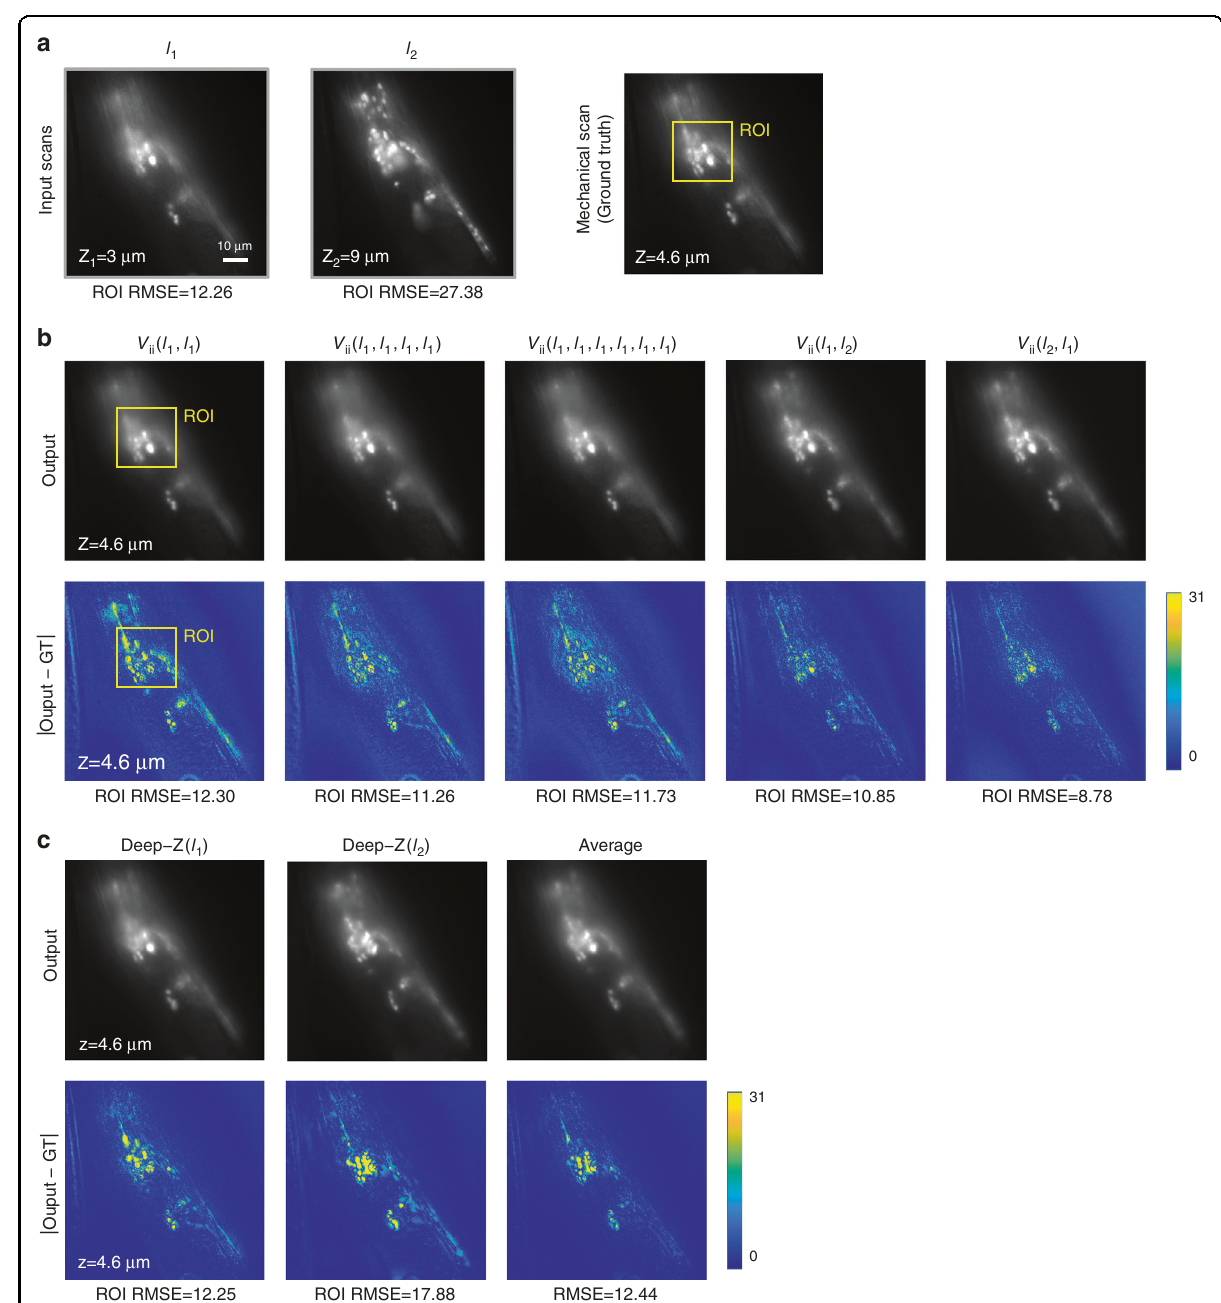
Fig. 7 Repetition invariance of Recurrent-MZ. Recurrent-MZ was trained with inputs ( M = 2) sorted by their relative distances ( dz ) to the output plane, but tested on a new sample by repeatedly feeding the input image ( I 1 ) to test its repetition invariance. a The input images and the ground truth image obtained by mechanical scanning (with an axial spacing of 0.2 μ m), b the Recurrent-MZ outputs and the corresponding difference maps of repeated I 1 , i.e., V ii ( I 1 , I 1 ), V ii ( I 1 , I 1 , I 1 , I 1 ) and V ii ( I 1 , I 1 , I 1 , I 1 , I 1 , I 1 ) as well as V ii ( I 1 , I 2 ) and V ii ( I 2 , I 1 ), c the outputs and corresponding difference maps of Deep-Z with a single input image ( I 1 or I 2 ), and the pixel-wise average of Deep-Z( I 1 ) and Deep-Z( I 2 ). All RMSE values are calculated based on the region of interest (ROI) marked by the yellow box. The range of grayscale images is 255 while that of the standard variance images is